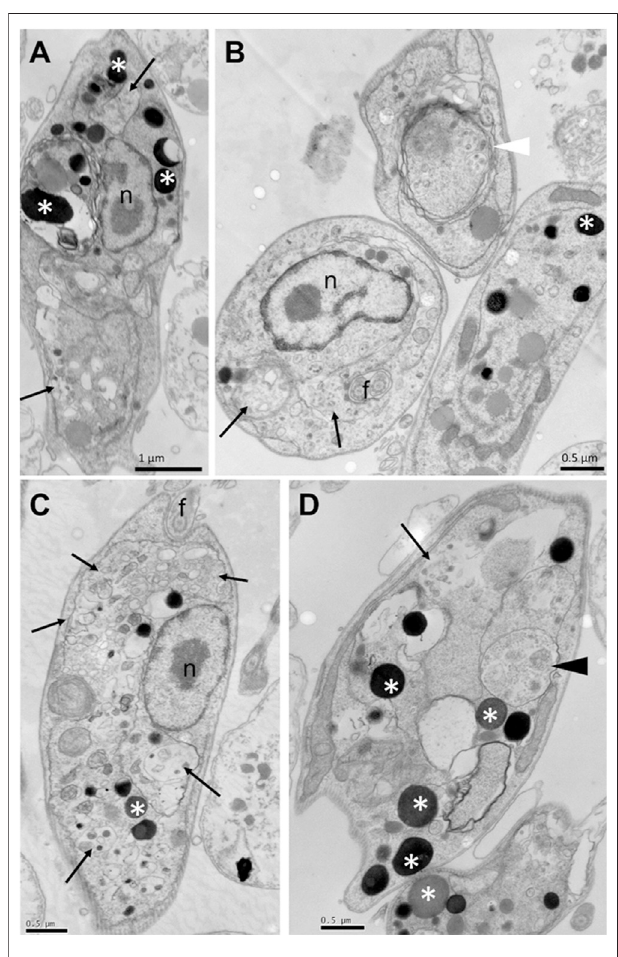
FIGURE 7 | Ultrastructural alterations of Leishmania amazonensis promastigote forms treated with luteolin at 25 μ g/mL for 24 h. Vacuoles containingmaterialofdifferentshapesand density(arrows), lipidbodies(white asterisks) (A – D) , several layers of circular membranes involving multivesicular bodies (white arrowhead) (B) , autophagosome-like vacuoles (black arrowhead) (D) . n: